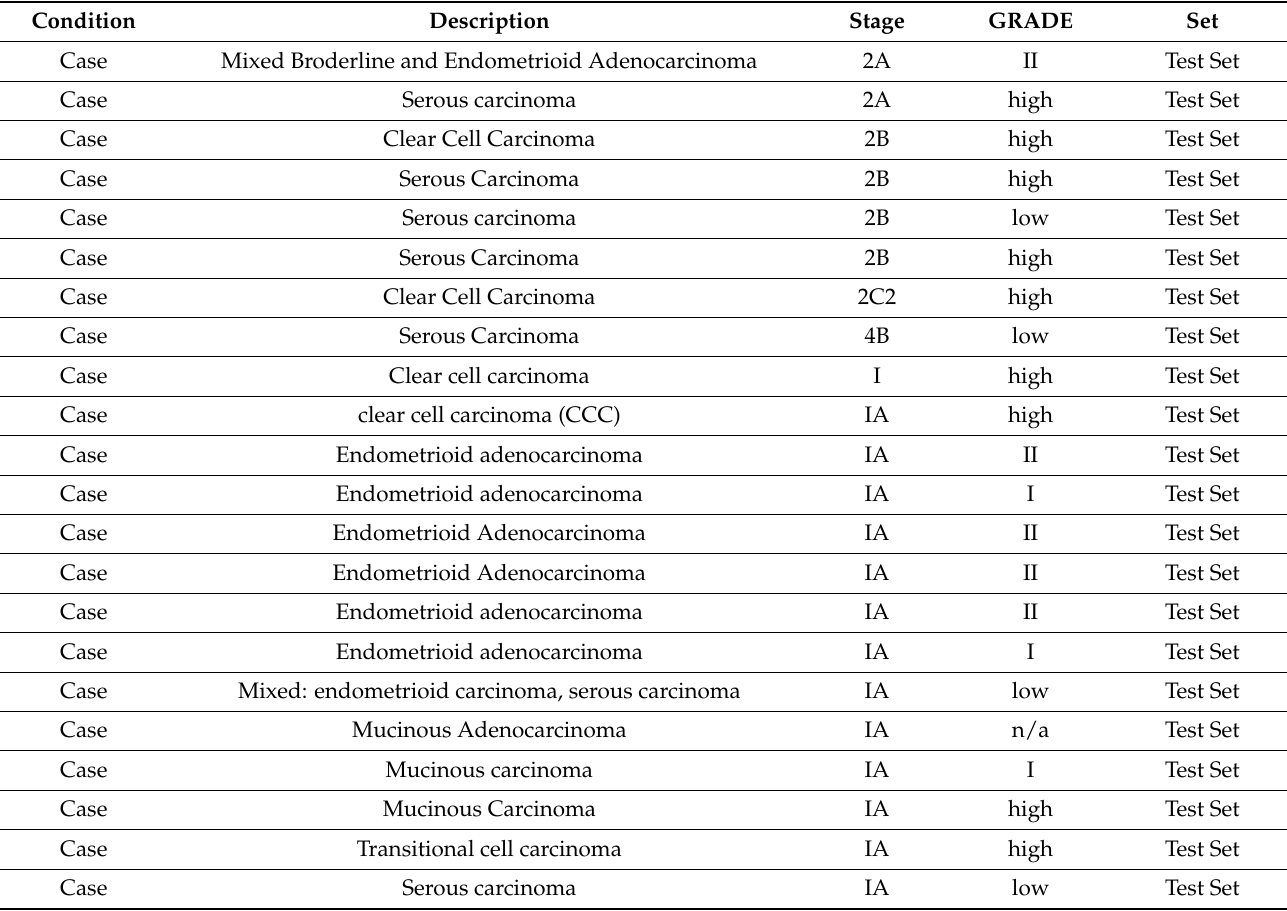
Table A1. Detailed information on cases and control subjects presenting with benign pelvic